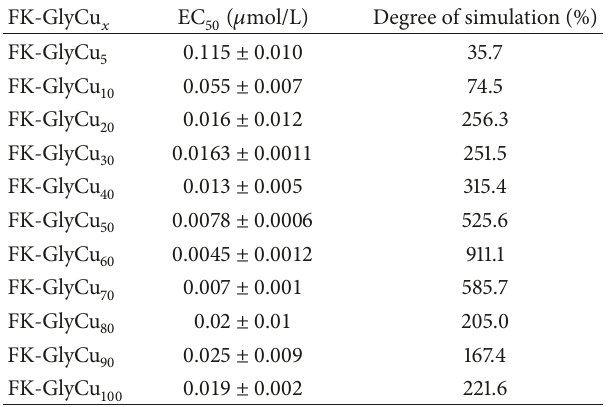
Table 6: The effect of the mount of Cu II for O 2∙− scavenging activity of FK-GlyCu 𝑥